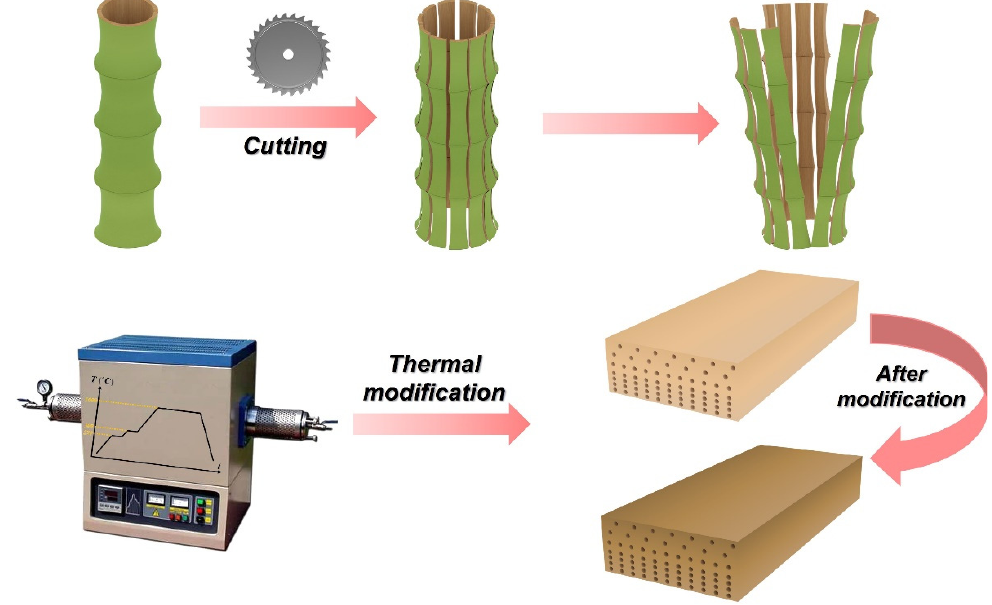
Figure 1. Schematic of the thermal modification process of the nitrogen heat treatment.